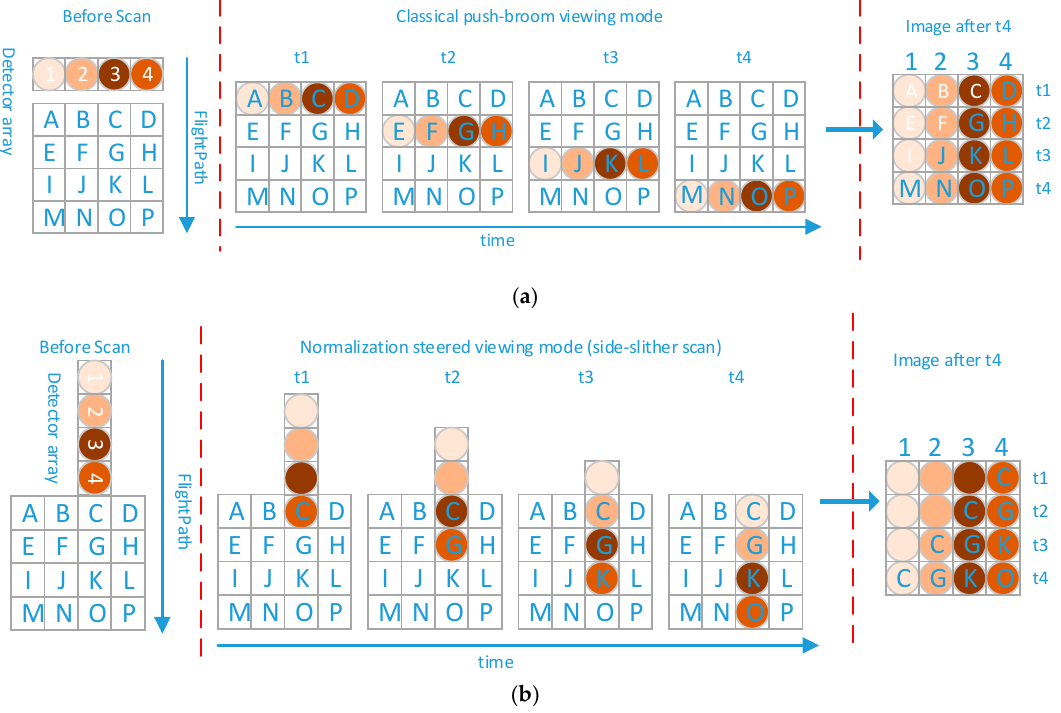
Figure 2. ( a ) Classical push-broom viewing mode; ( b ) normalization-steered viewing mode (side-slither scan).